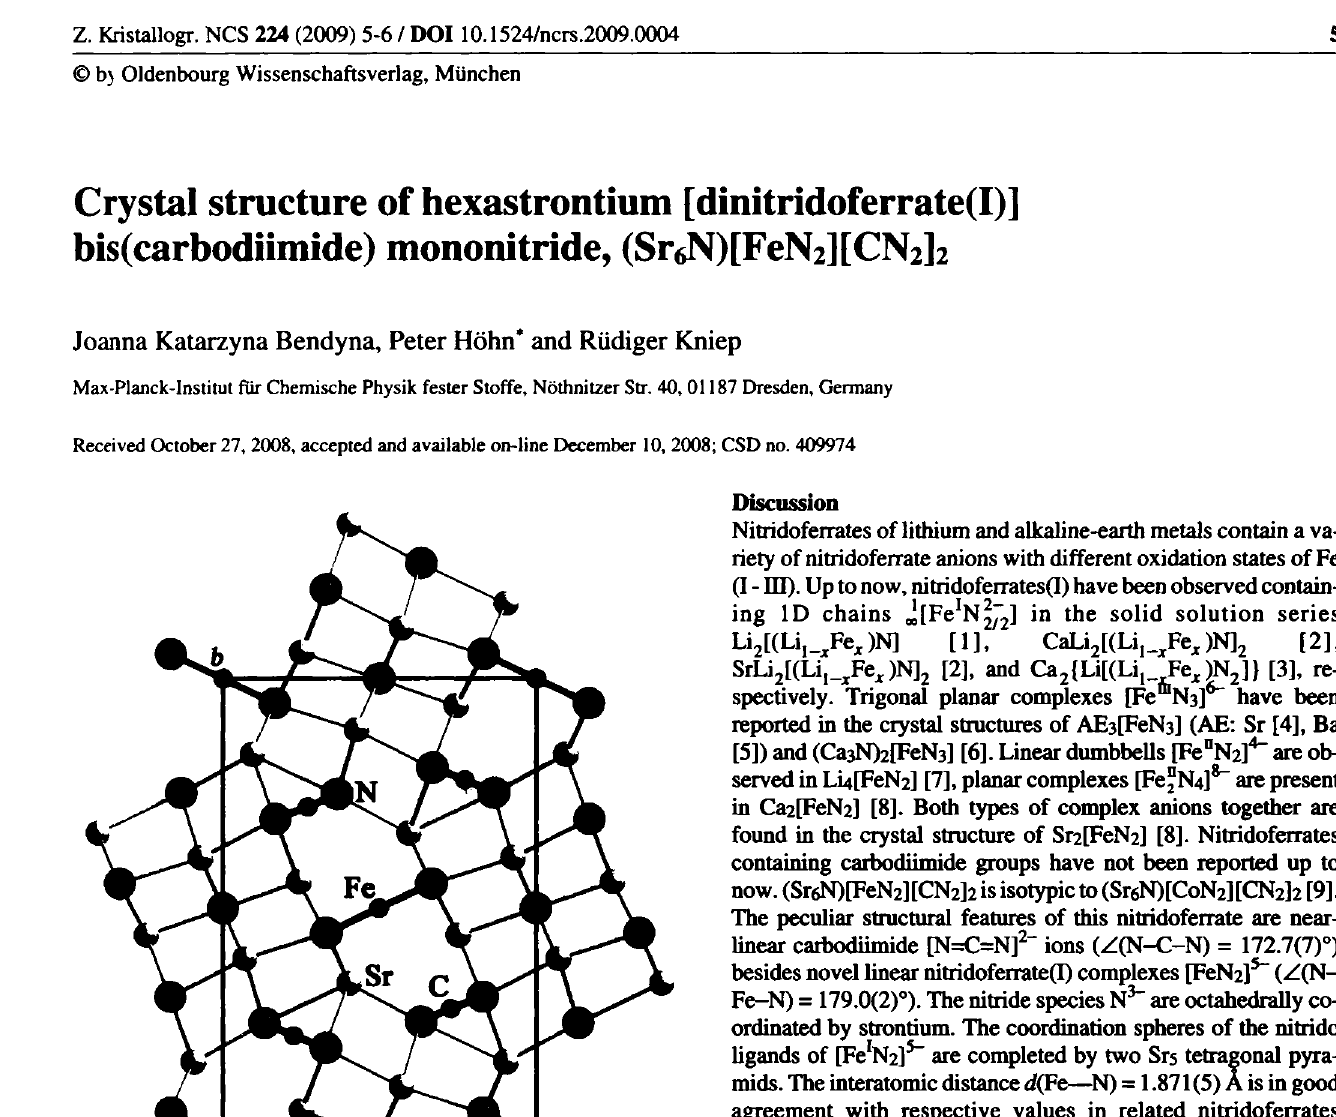
Table 1. Data collection and handling. Crystal: